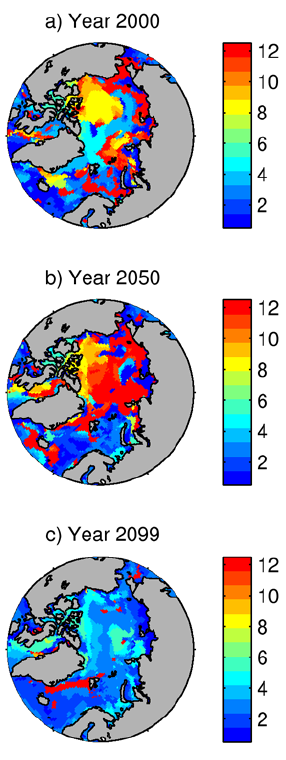
Fig. 7. Number of the month (January = 1) in which minimum annual values of (cid:127) a occur in year 2000 (a) , 2050 (b) and 2099 (c)